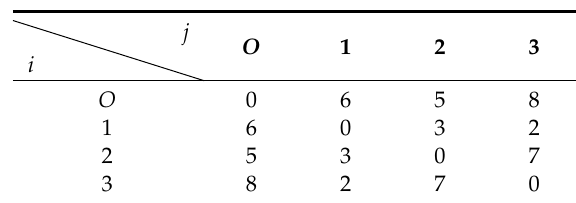
Table 4. Distance